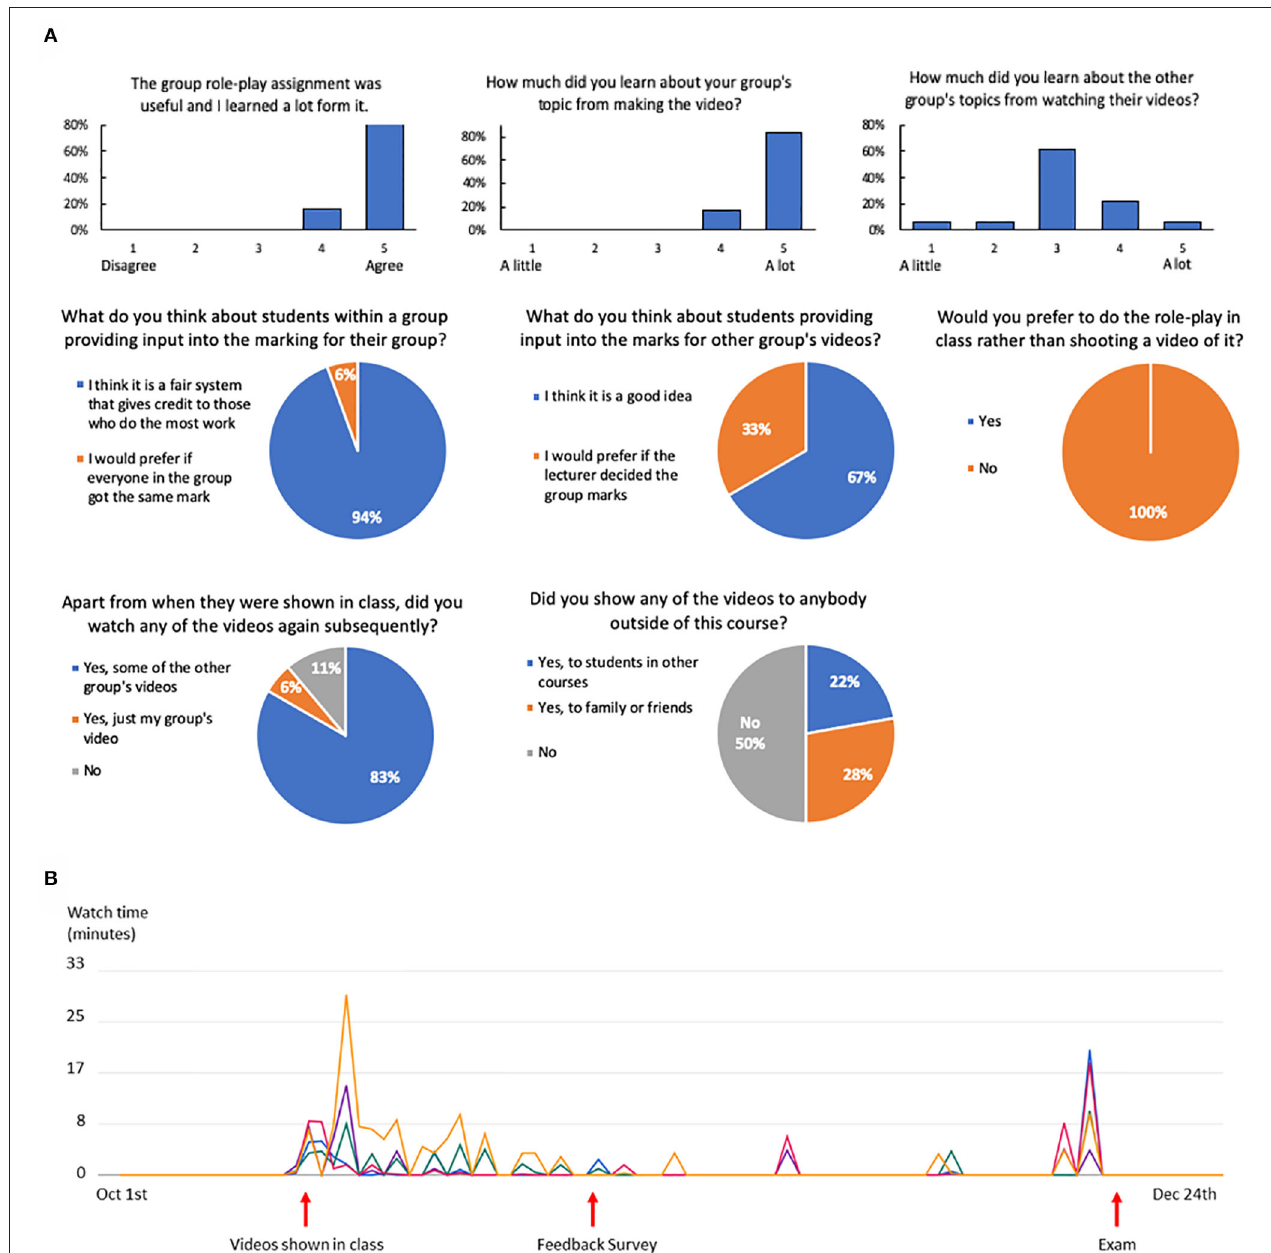
FIGURE 3 | Student feedback survey results and watch time data from YouTube for five role-play videos. (A) Results of an online student feedback survey conducted using Google Forms 3 weeks after completion of the role-play project. Eighteen responses to the survey were obtained, which represents a response rate of approximately 40%. The full survey questionnaire is provided as Supplemental Data . (B) Watch time data for five of the role-play videos (each color-coded differently) was obtained using YouTube analytics. The timing of the end of the assignment when the videos were first shown in class is indicated, as well as the timing of